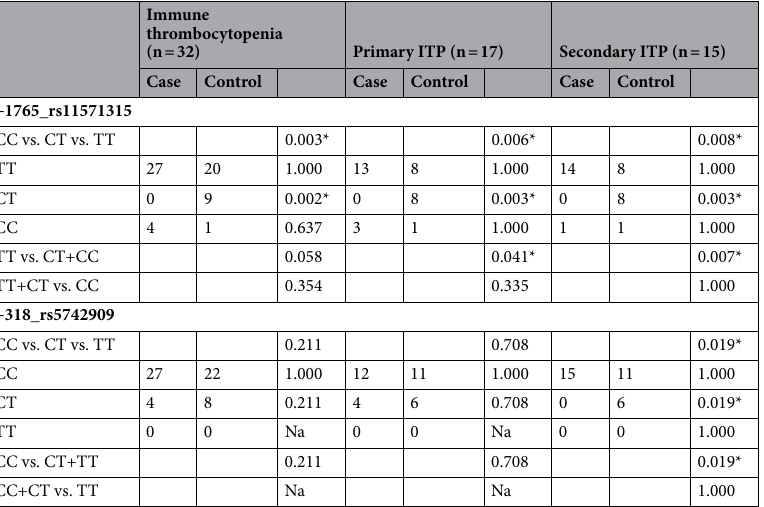
Table 3. Statistical analysis of CTLA4 SNPs and ITP. p values were counted from Chi-square test or Fisher’s exact test, where “*” means that it had significant difference between test group and control group. 95% CI 95% confidence interval; NA not applicable.